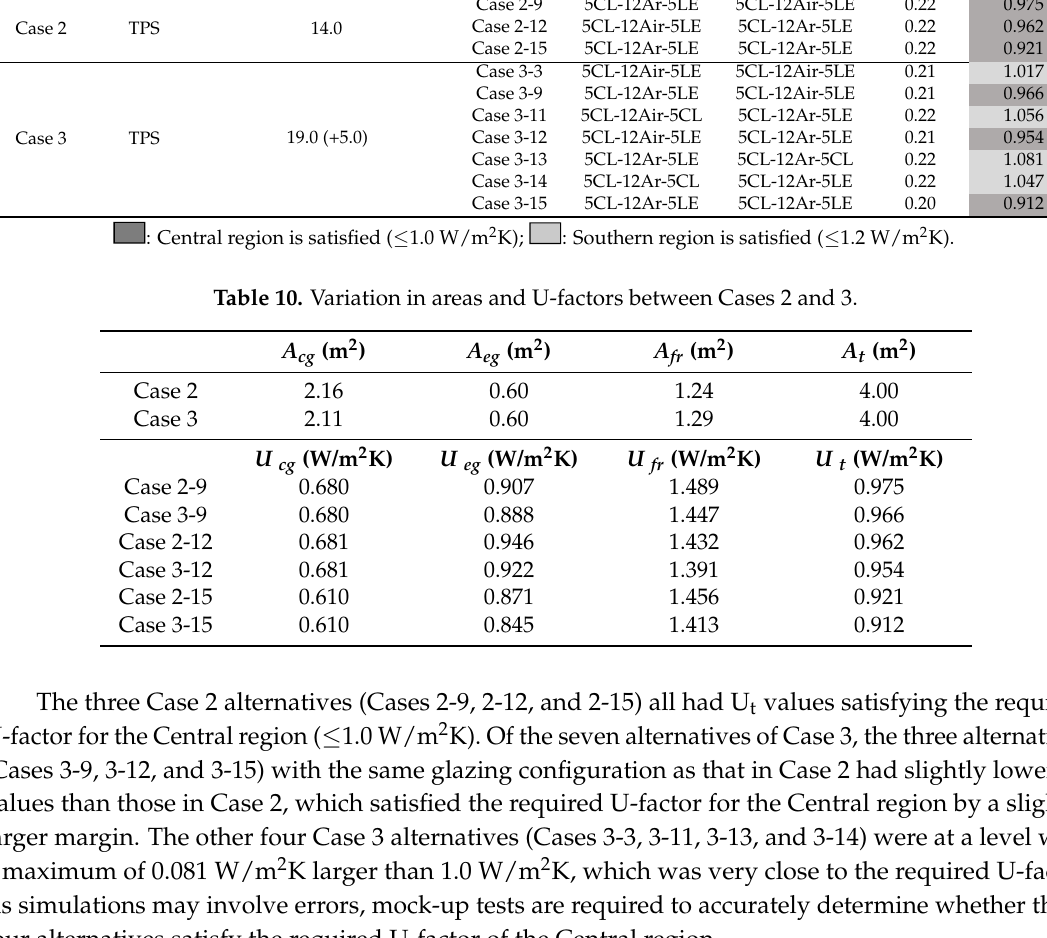
Table 8. TDR s and indoor surface temperatures at the glazing edge (E1 in Figure 7a).